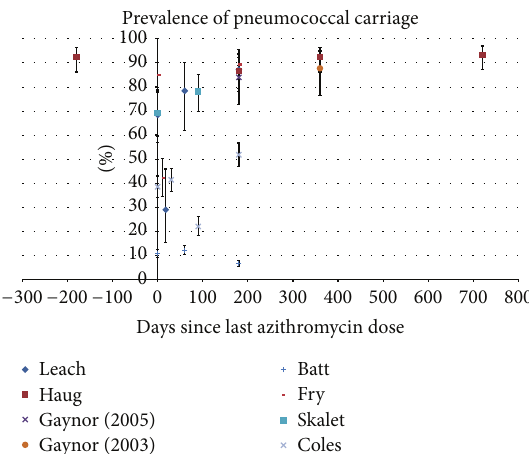
Figure 4: Prevalence of pneumococcal carriage, demonstrating the effect of azithromycin administration. The error bars show 95% confidence intervals about the